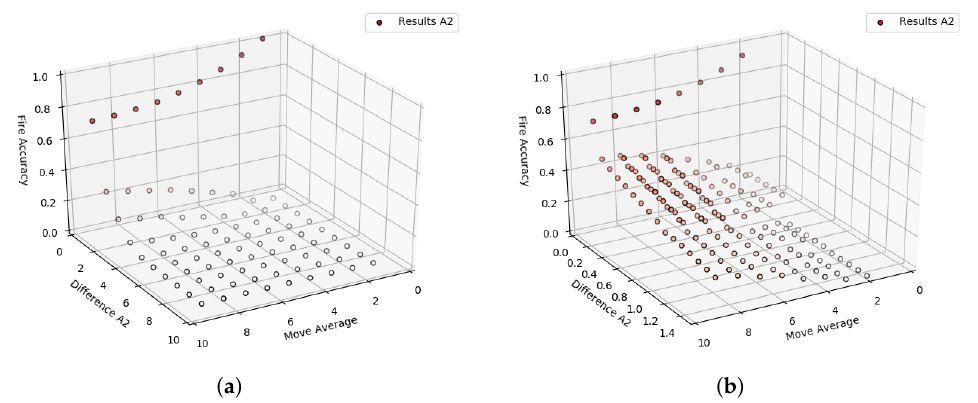
Figure 13. Graph visually demonstrating the result of the A 2 approach with the mentioned intervals for D and n from 0 to 10 stepping 1. ( a ) A 2’s results with D range 0 to 10 stepping 1. ( b ) A 2’s results with D range 0 to 0.9 stepping